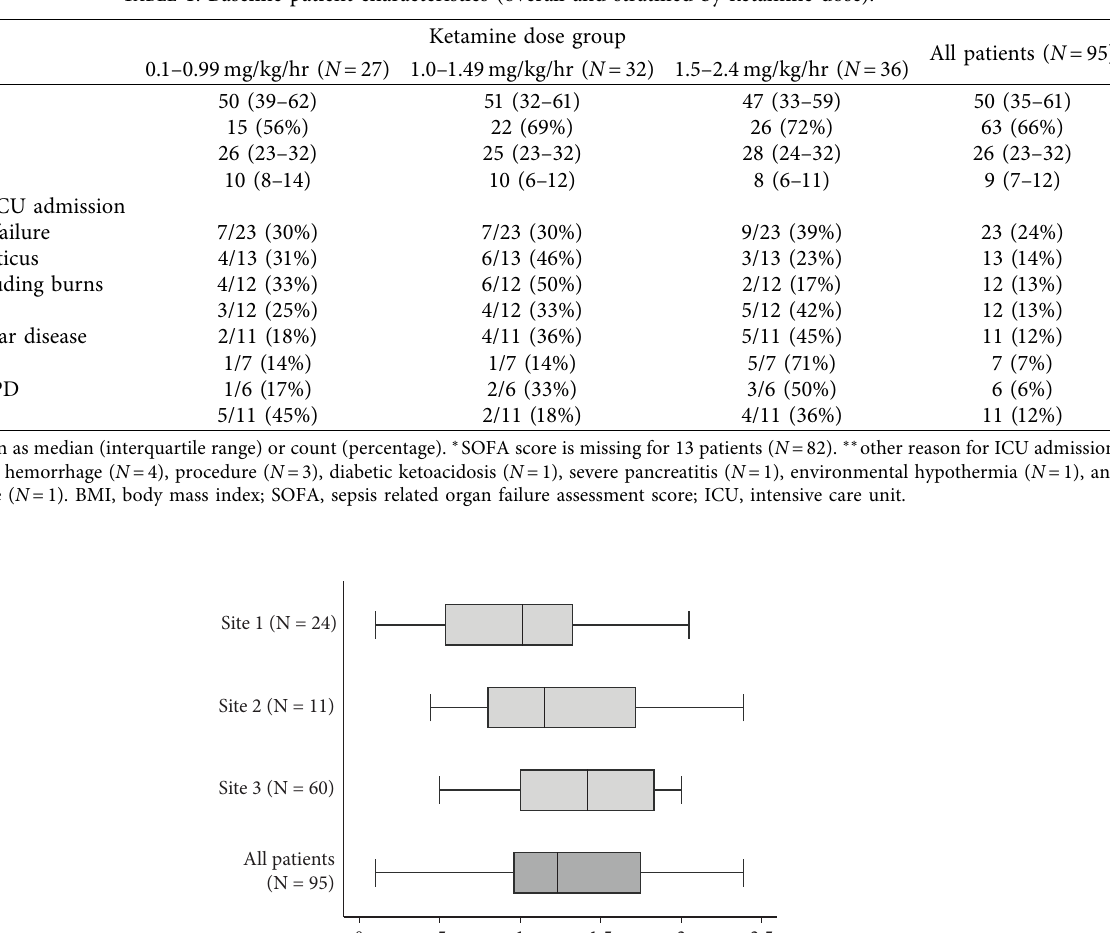
Table 1: Baseline patient characteristics (overall and stratifed by ketamine dose).